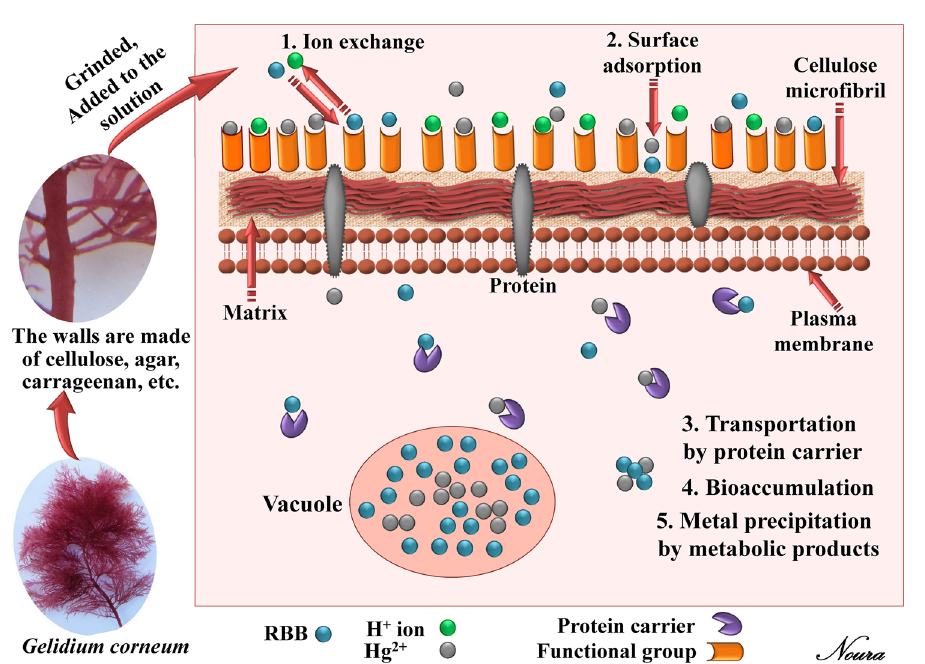
Figure 10. Schematic diagram showing the biosorption mechanisms of metal ions and dye by algal